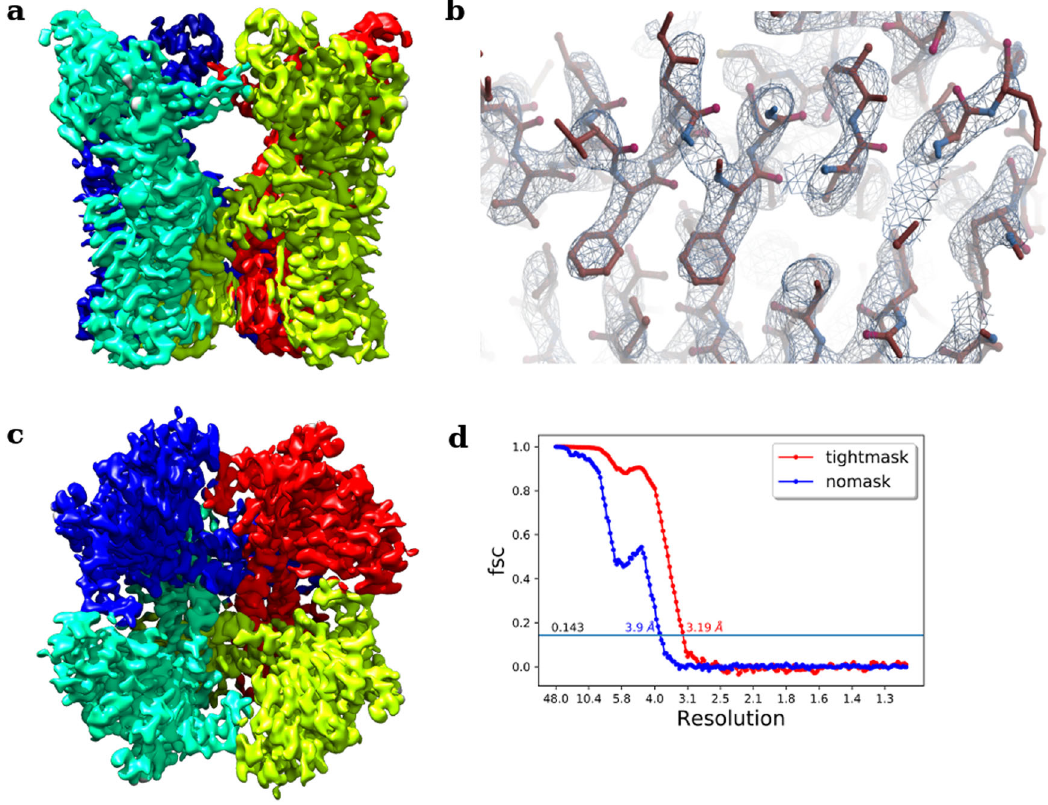
Fig. 5 3D cryo-EM density of TRPV1 obtained by implementing additional re fi nement steps to the uniform pipeline scheme. a Side view, b highlighted view of the side chains fi tted (PDB 3j5p) into the EM density, c top view, and d FSC curve for TRPV1 showing resolution ( Å ) at gold standard cutoff (0.143). COMMUNICATIONS BIOLOGY| (2021) 4:200